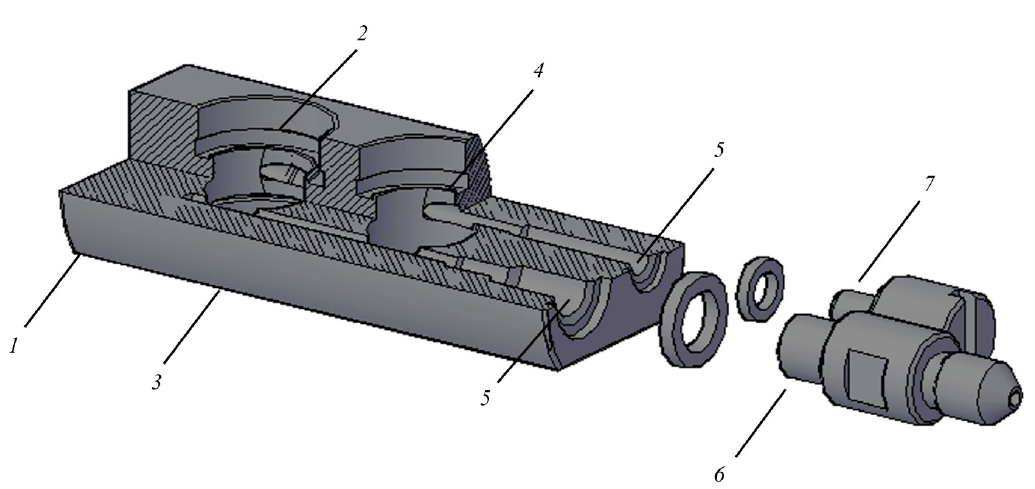
Figure 2. Schematic diagram of titanium pressure chamber for studying samples at elevated pressure: